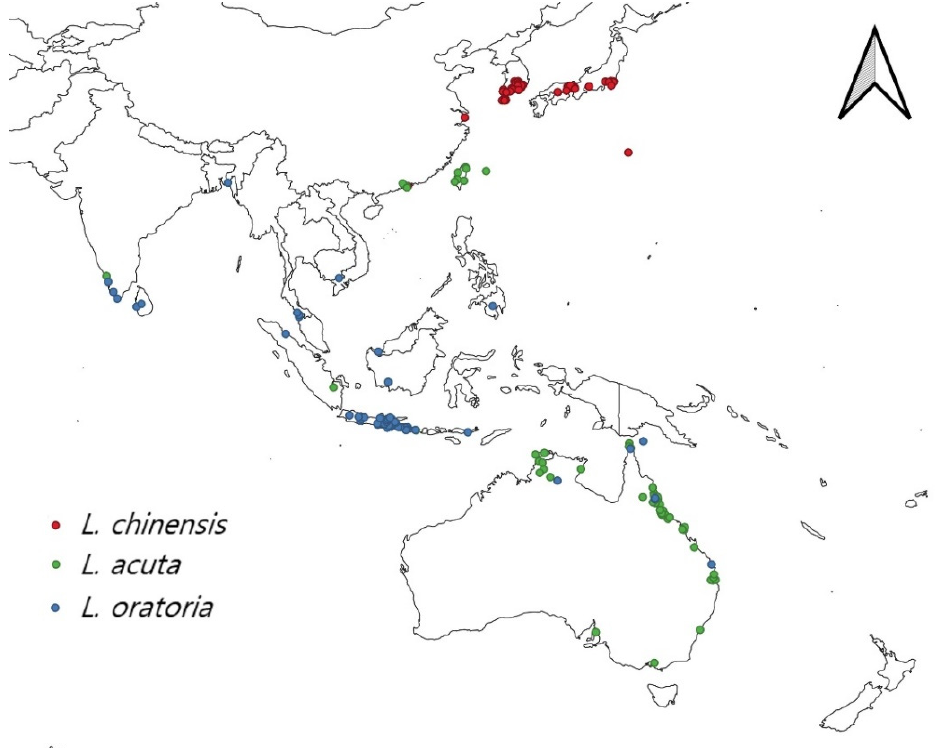
Figure 1. Occurrence records for three Leptocorisa